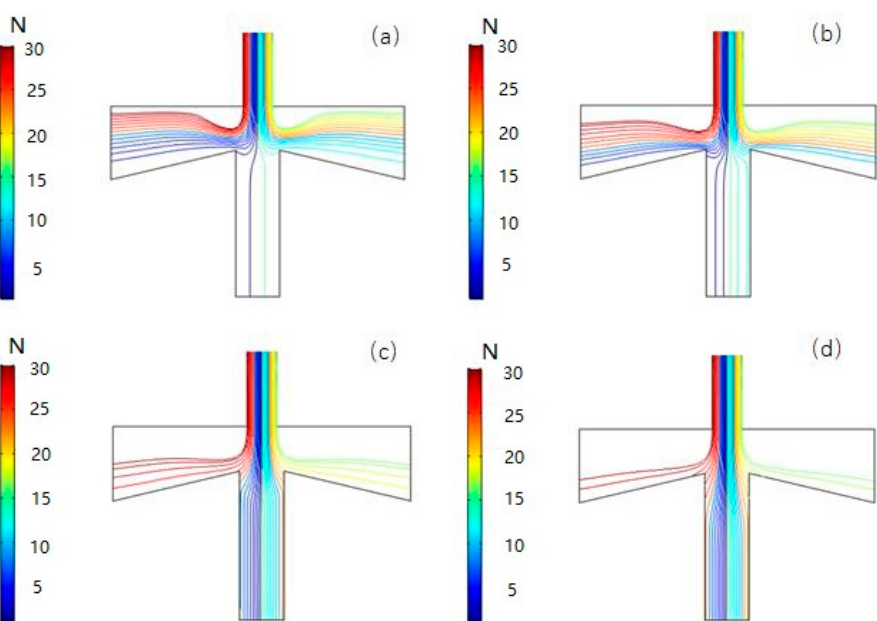
Figure 9. Particle motion trajectory of PM0.5 ( a ), PM2.5 ( b ), PM5 ( c ), and PM7 ( d ). In the figures, the trajectories of particles with different colors represent the number of each particle released at the inlet.